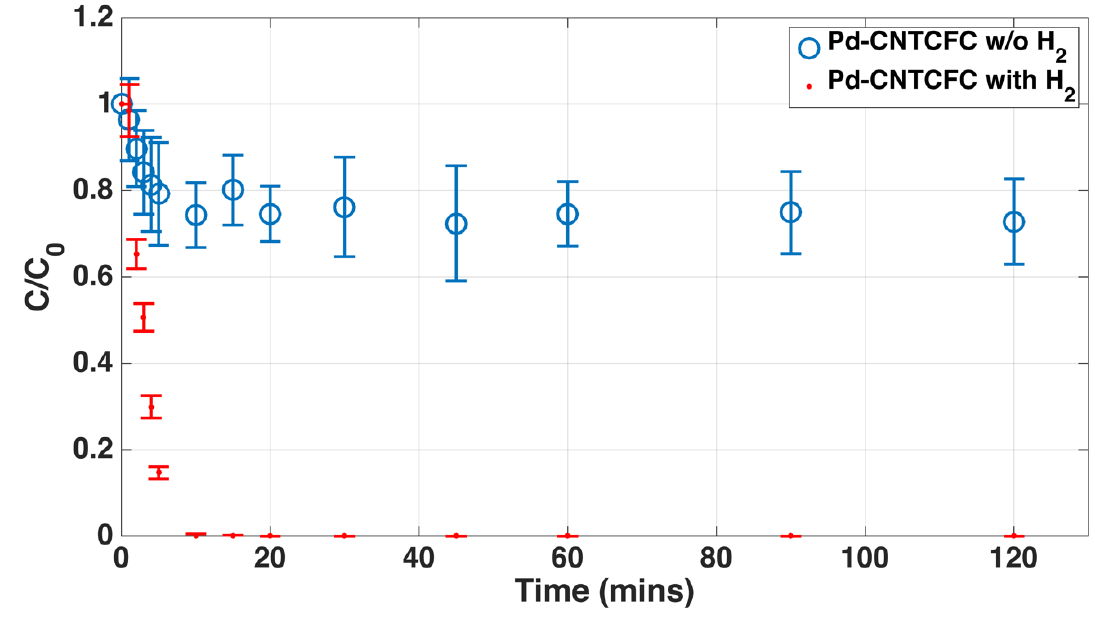
Figure 10. TCS catalytic degradation in aqueous environment, nitrogen balanced hydrogen (5% H 2 ) mixture was supplied into the reactor, and the pressure was kept at a constant of 1 atm. “Reproduced with permission from [158]. Elsevier, 2021.” [158]).